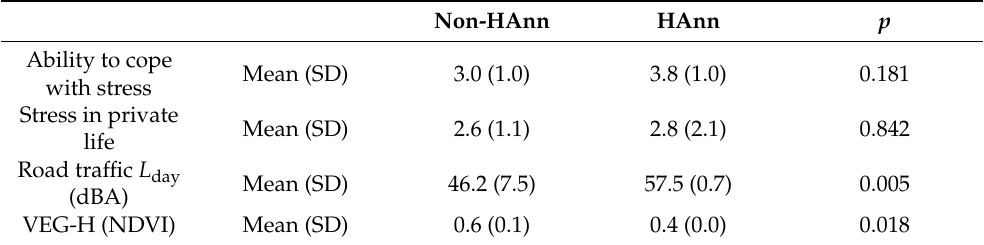
Table 5. Differences in stress and exposure characteristics in a 50 m buffer around home between the non-highly (Non-HAnn) and highly annoyed persons (HAnn) by road traffic noise, and p